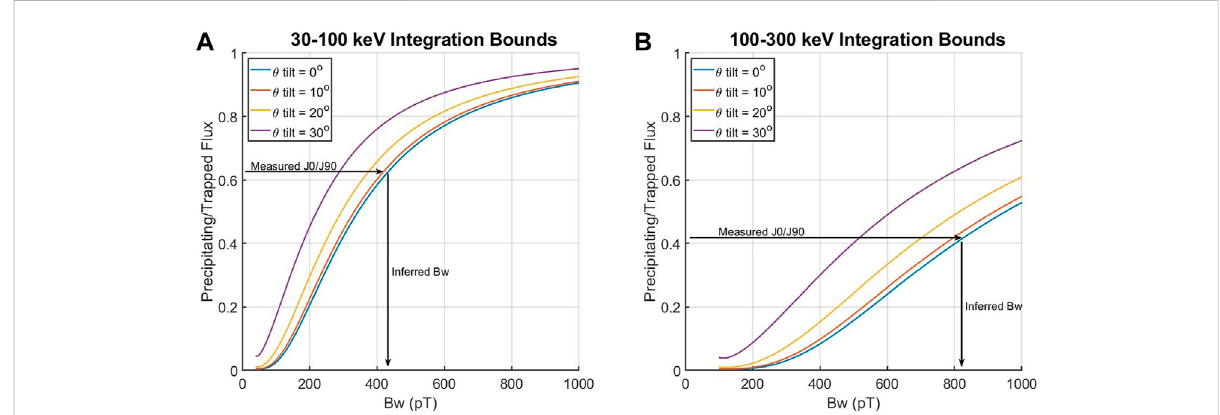
FIGURE 3 Sample calculations of the predicted ratio of precipitating to trapped fl ux using Eqs 10, 11, 12, 13, 14, 15, with different detector tilt angles. The inferred chorus intensity is obtained by fi nding where the curve for J 0 / J 90 intersects the observed value by MEPED, then reading the B w value at that intersection. The black arrows show an example of this process: at 15:00 UT, 03:00 MLT, and L = 5, the measured fl ux ratio in the 30 – 100 keV band (cid:2) 0 . 62, which gives an inferred chorus intensity of B w (cid:2) 435 pT from plot (A) . At the same time, the measured fl ux ratio in the was J 0 J 90 (cid:2) 0 . 42, so the inferred chorus intensity in plot (B) is B w (cid:2) 825 pT. The discrepancy in the fl ux ratio J 100 – 300 keV band is J 0 J 90 energy bands is due to chorus diffusion favoring electron energies less than 100 keV (see Figure 1). However, the inferred values of the chorus intensity should be the same for each energy band since the observed precipitation in each band is caused by the same chorus wave. This discrepancy between the inferred B w values is the subject of Section